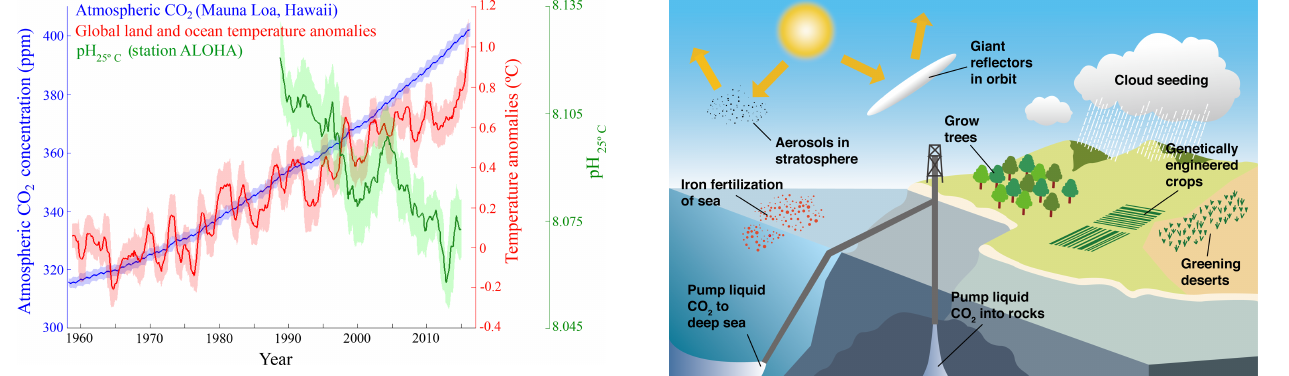
Figure 1. Diagram showing the monthly atmospheric CO 2 con- centrations (ppm) (blue) measured at the Mauna Loa Observa- tory, Hawaii (http://www.esrl.noaa.gov/gmd/ccgg/trends/data.html, last access: 6 September 2018); global monthly land-surface air and sea surface temperature anomalies ( ◦ C) (red) (http://data.giss. nasa.gov/gistemp/, last access: 6 September 2018); and pH (green) measured at station ALOHA in the central North Pacific (http:// hahana.soest.hawaii.edu/hot/products/HOT_surface_CO2.txt). The data values represent moving average values for 12 months and shading indicates the standard deviation for 12 months.